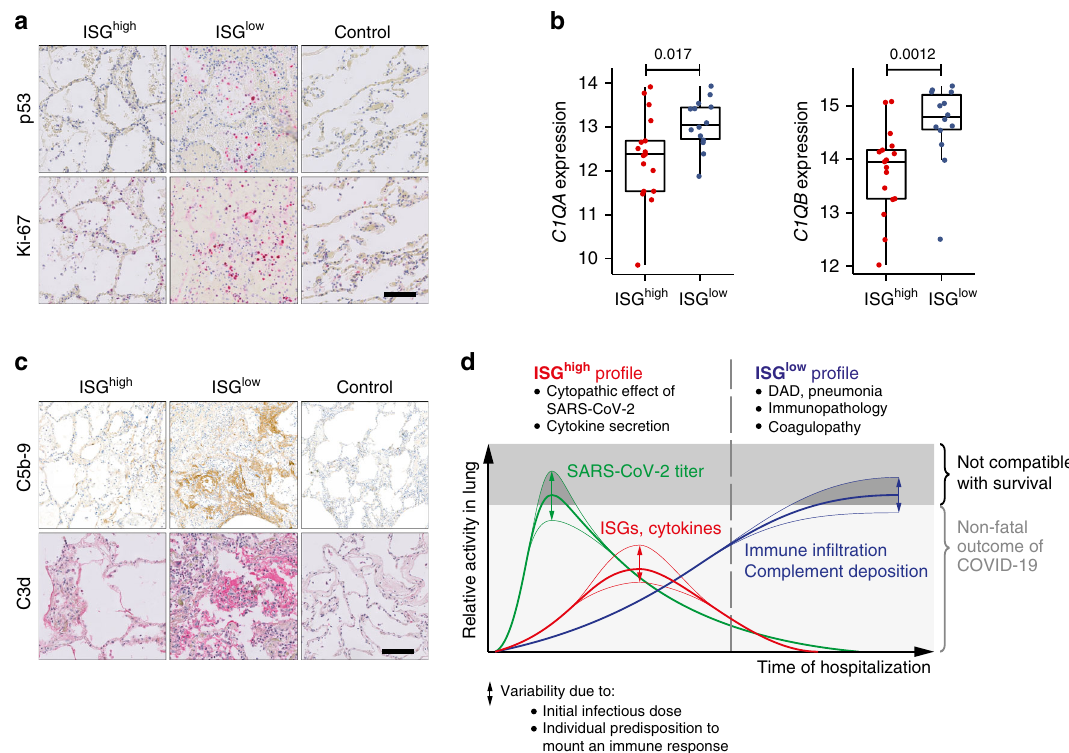
Fig. 6 Molecular characteristics of the ISG high and ISG low COVID-19 lung pro fi les. a Representative immunohistochemistry for p53 and Ki67. Size bar 100 μ m. At least two different tissue blocks from different areas of the lungs were evaluated for each case. b Expression of C1QA and C1QB in ISG high and ISG low lung samples ( n = 31 independent samples). Box-plots elements indicate the median (center line), upper, and lower quartiles (box limits). Whiskers extend to the most extreme value included in 1.5× interquartile range. Groups were compared using a two-sided Wilcoxon rank-sum test. c Representative IHC stainings for complement activation products C5b-9 and C3d in ISG high , ISG low COVID-19, and normal control lungs. Size bar 100 μ m. At least two different tissue blocks from different areas of the lungs were evaluated for each case. ISG high samples, red; ISG low samples, blue. d Schematic time course of COVID-19 lung disease based on lung autopsy fi ndings. Early in the disease, an ISG high lung pro fi le is observed, with high viral load, high expression of cytokines and ISGs, and sparse immune in fi ltrates. Late in the disease, an ISG low lung pro fi le is observed, with low viral load, low local expression of cytokines and ISGs, and strong in fi ltration of macrophages and lymphocytes. Patients who die early are not able to adequately control SARS-CoV-2, while patients who die late suffer from DAD and immunopathology. Infectious dose and individual predisposition to mount immune responses likely de fi ne whether or not a patient survives COVID-19. Green line: Relative viral loads, red line: Relative expression of lung ISGs and cytokines, blue line: pulmonary immune in fi ltrates and complement deposition. Dark gray area: lethal outcomes, arrows: individual